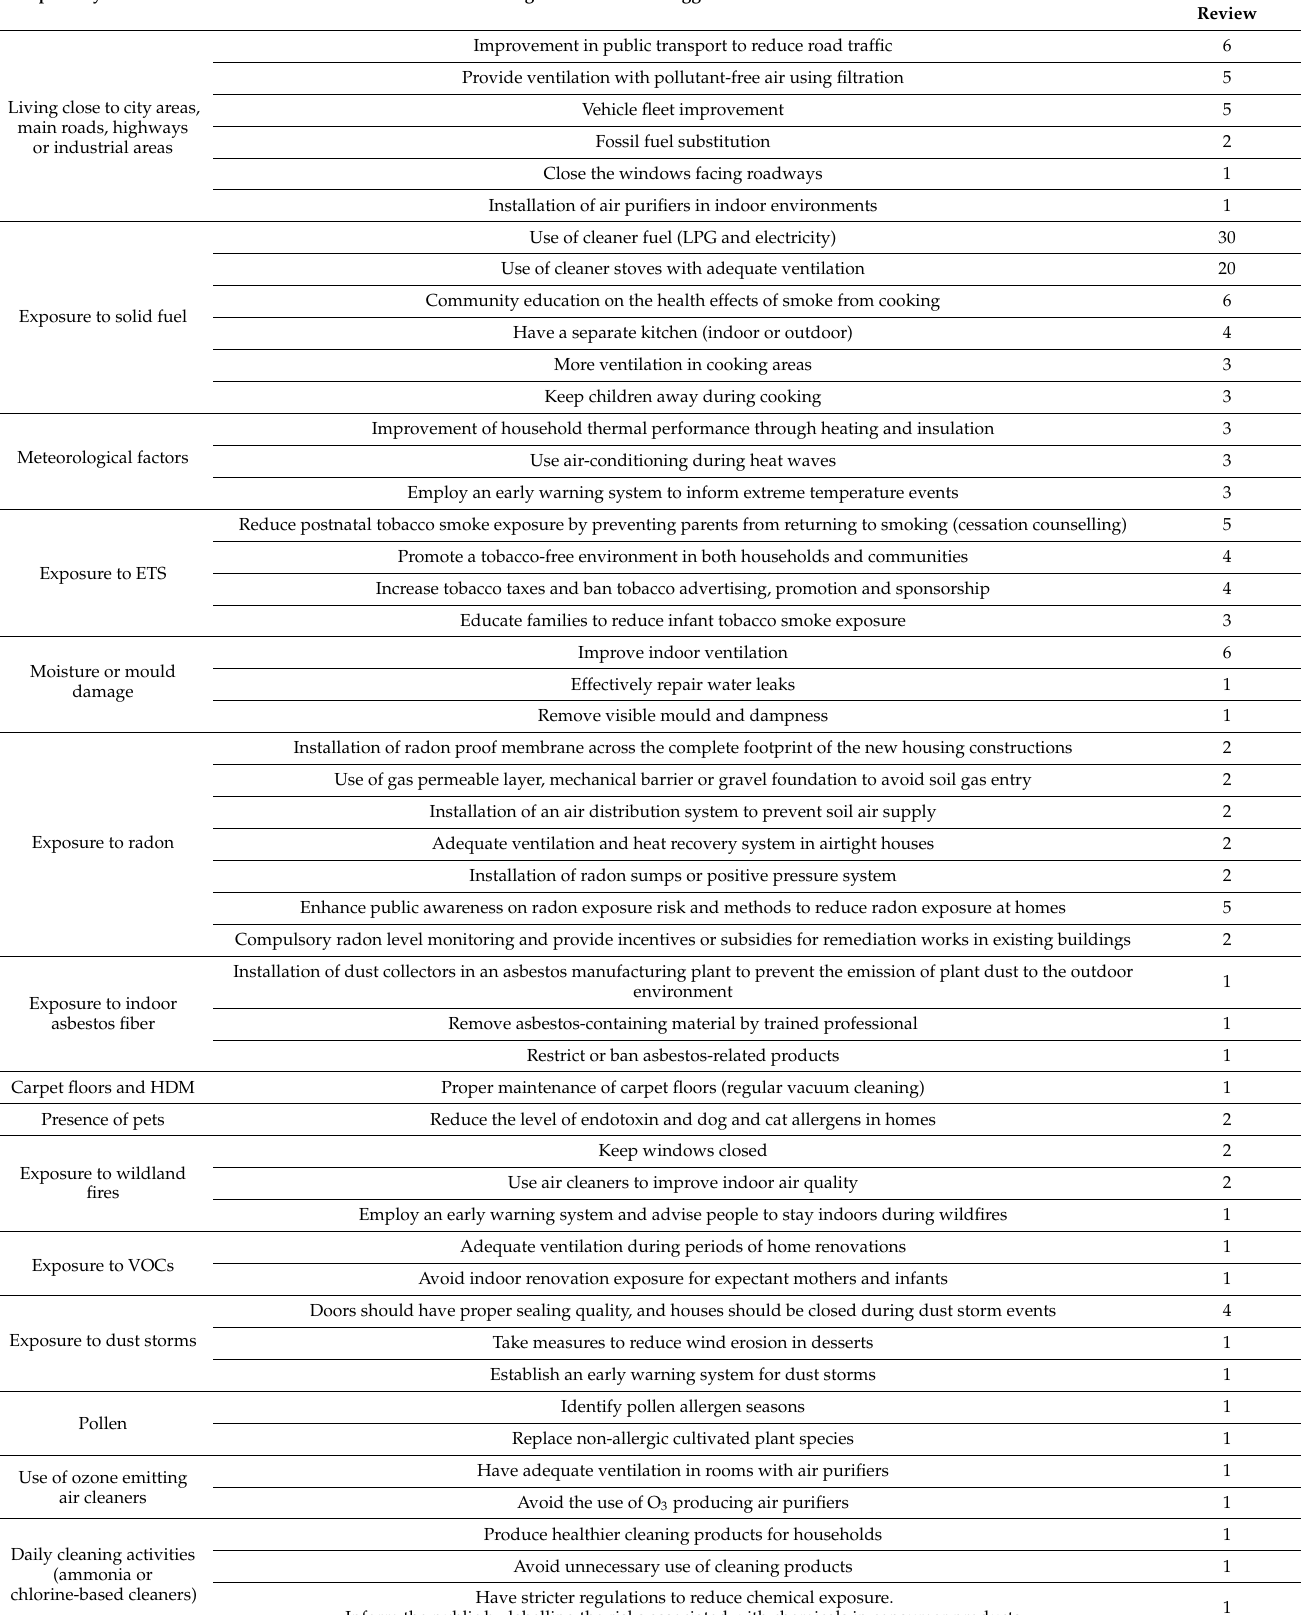
Table 3. Suggested mitigation solutions and count of the number of times they are proposed by publications considered in this